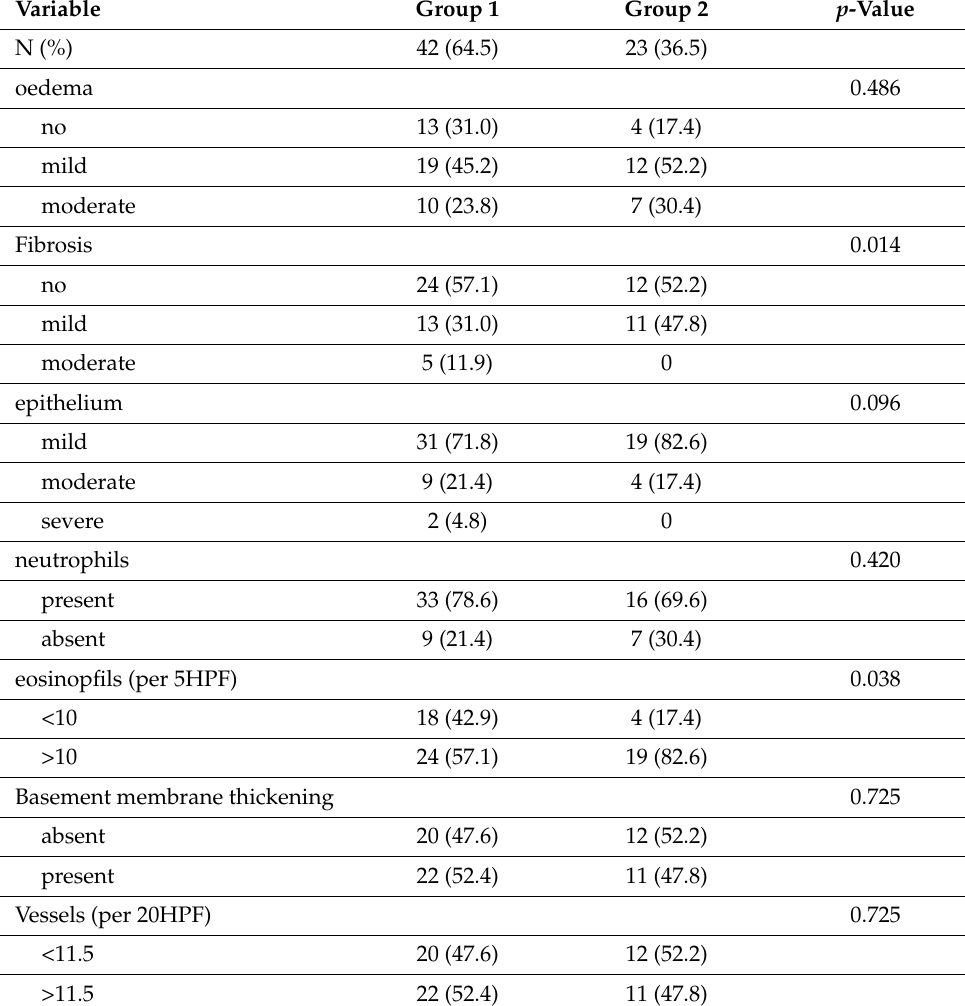
Table 2. Histopatologic features from patients with chronic rhinosinustis with nasal